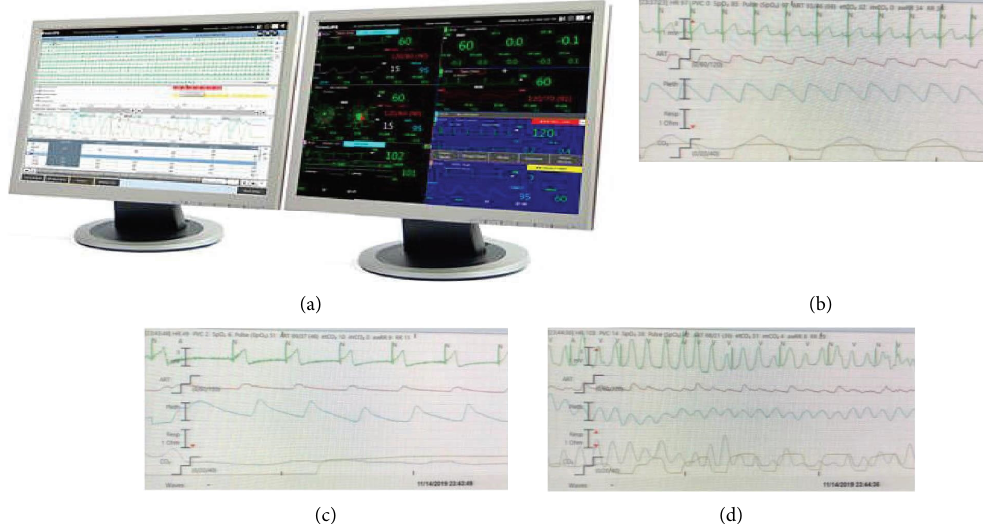
Figure 2: (a) Display of central patient monitor (a) which was used to capture prearrest and intraarrest data on vital parameters, cardiac rhythm, arterial line tracing, end-tidal CO 2 , and pulse-oximetry waveform for data-driven debriefng. (b)–(d) An example of central monitor data representing prearrest, intraarrest, and ongoing CPR,